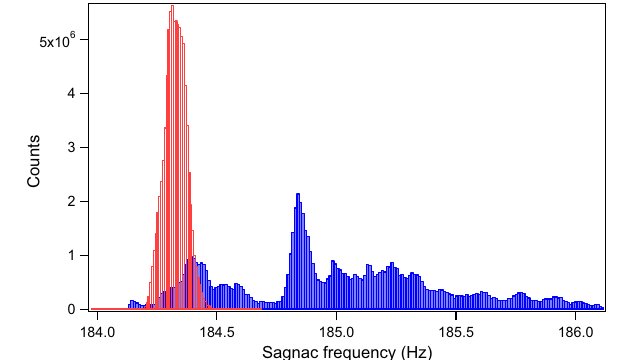
Fig. 4 Comparison of the histograms of the Sagnac frequency esti- matedwiththestandardmethod(blue)andbythenewone(red).Clearly thenewmethodleadstoanarrowerandmoreGaussian-likedistribution, with mean value 184 . 29 Hz